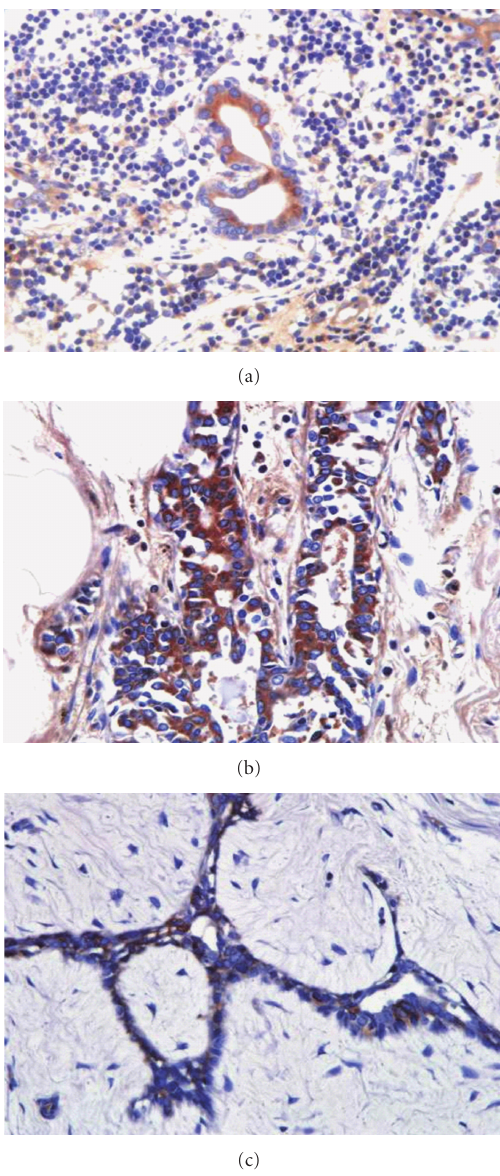
Figure 7: Autoantibody reacting to the patient’s own (a), other DM patient’s (b), and non-DM patient’s (c) breast tissue. Using the patient’s serum as the primary antibody, ductal epithelium showed positive staining at a 1 :200 dilution.